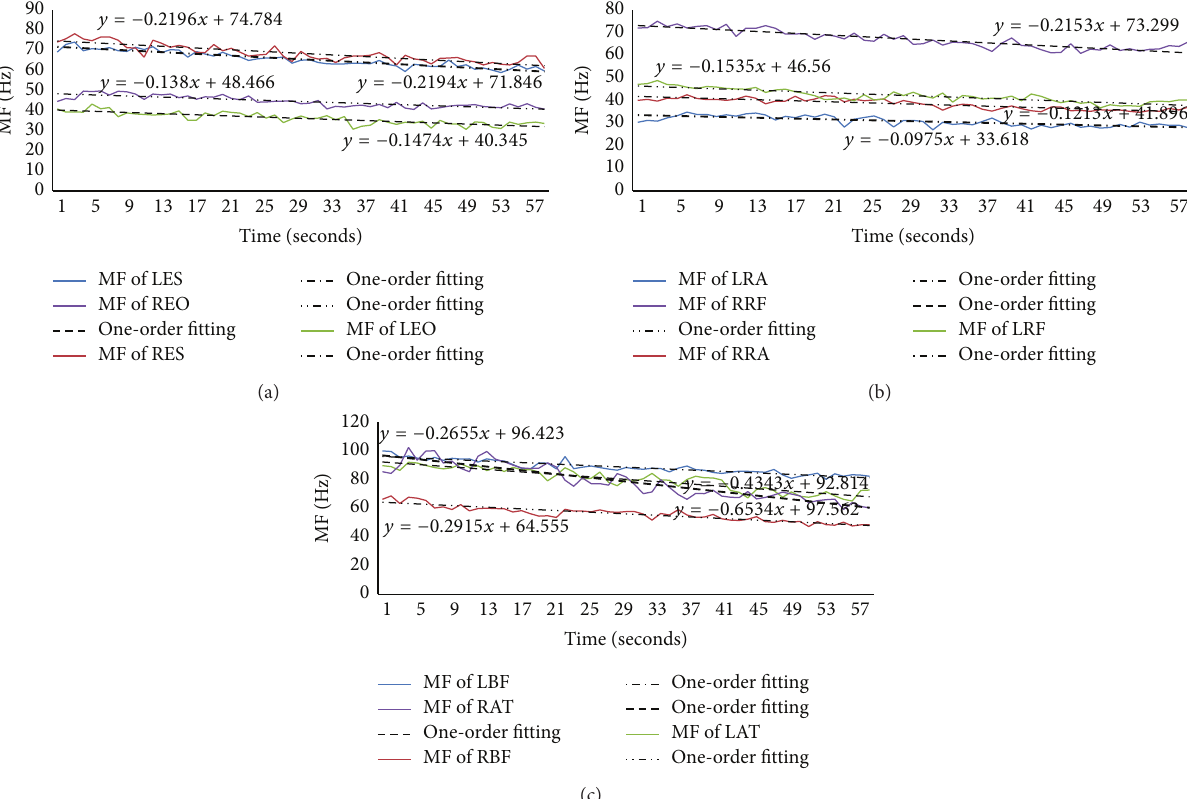
Figure 9: (a) The MF of left and right sides of ES and EO muscles and their one-order fitting during the unilateral bridge (lifting right leg). (b) The MF of left and right sides of RA and RF muscles and their one-order fitting during the unilateral bridge (lifting right leg). (c) The MF of left and right sides of BF and AT muscles and their one-order fitting during the unilateral bridge (lifting right